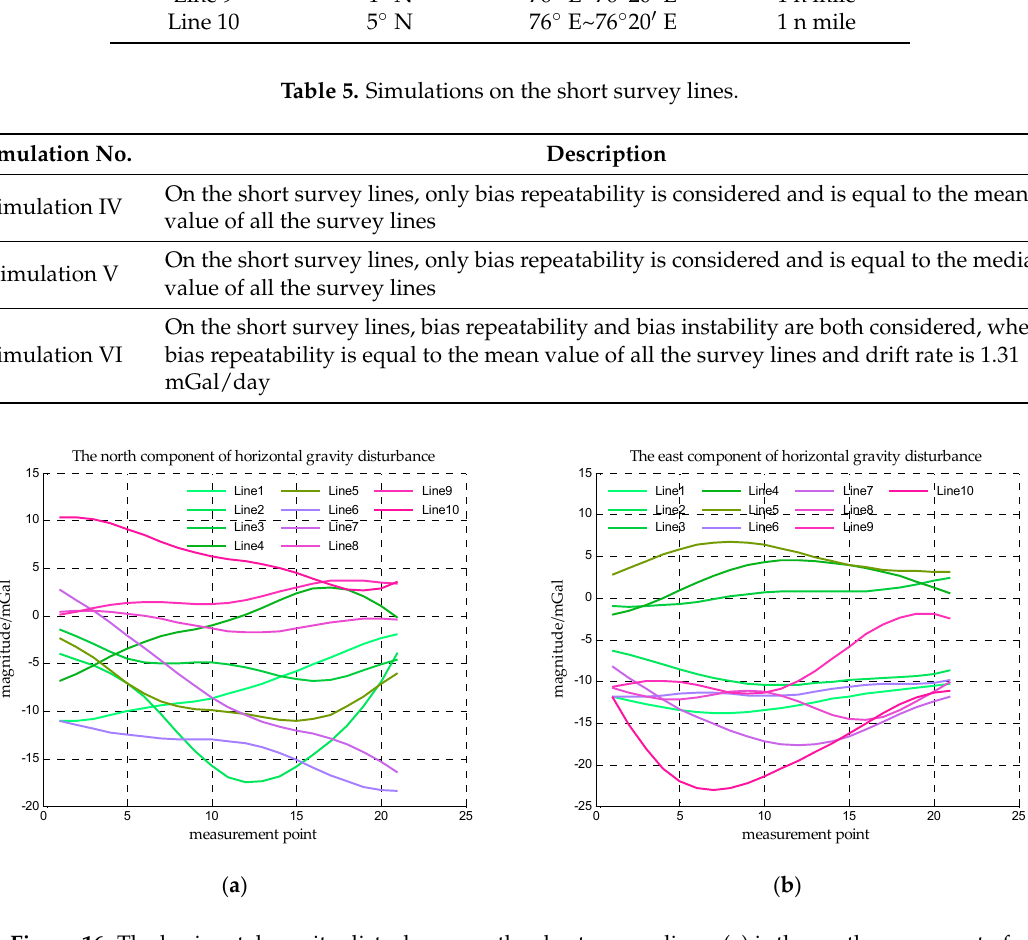
Figure 16. The horizontal gravity disturbance on the short survey lines. ( a ) is the north component of horizontal gravity disturbance on the short survey lines and ( b ) is the east component of horizontal gravity disturbance on the short survey lines.